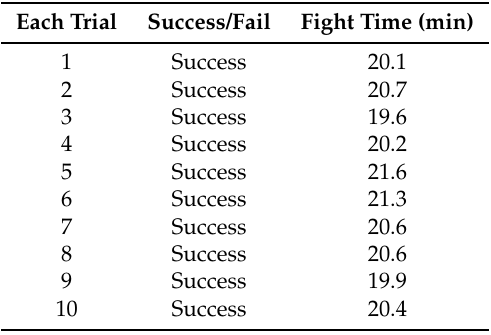
Table 3. Success rate and flight time to reach a goal of Fisheye HVIN.